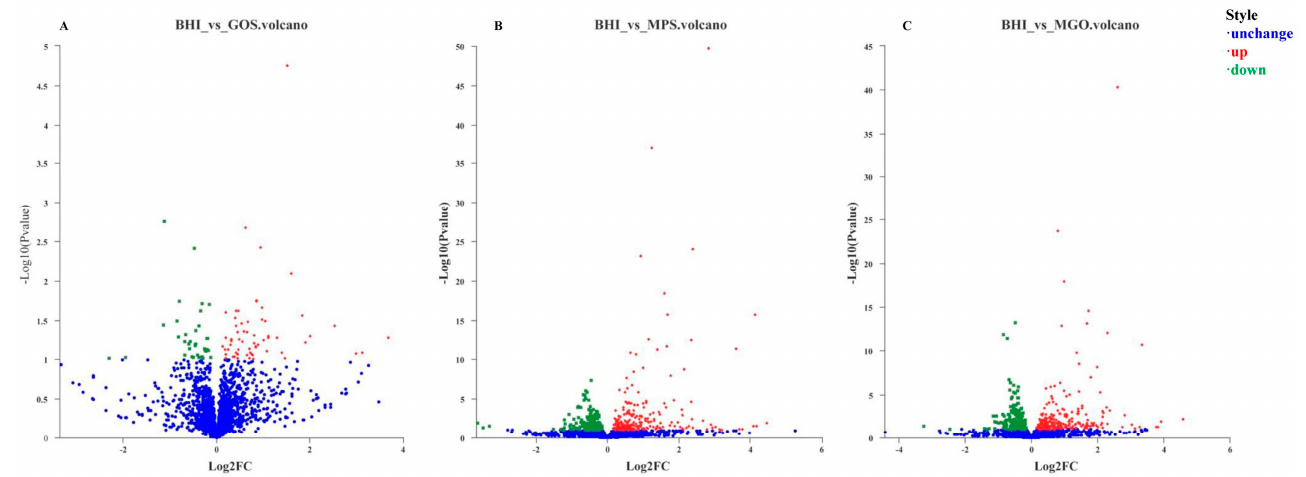
Figure 3. Volcano plots of DEGs in A. muciniphila after different prebiotic treatments. Volcano plot of DEGs in GOS ( A ); volcano plot of DEGs in MPS ( B ); volcano plot of DEGs in MGO ( C ).